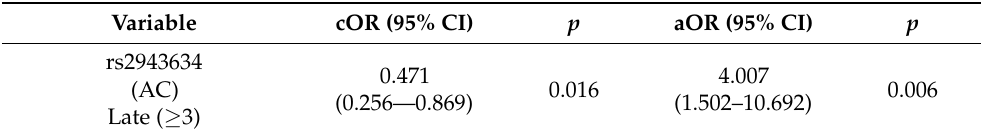
Table 3. Regression analysis of genetic polymorphism regarding the risk of developing cardiovascular events (the dependent variable is outcome, outcome is